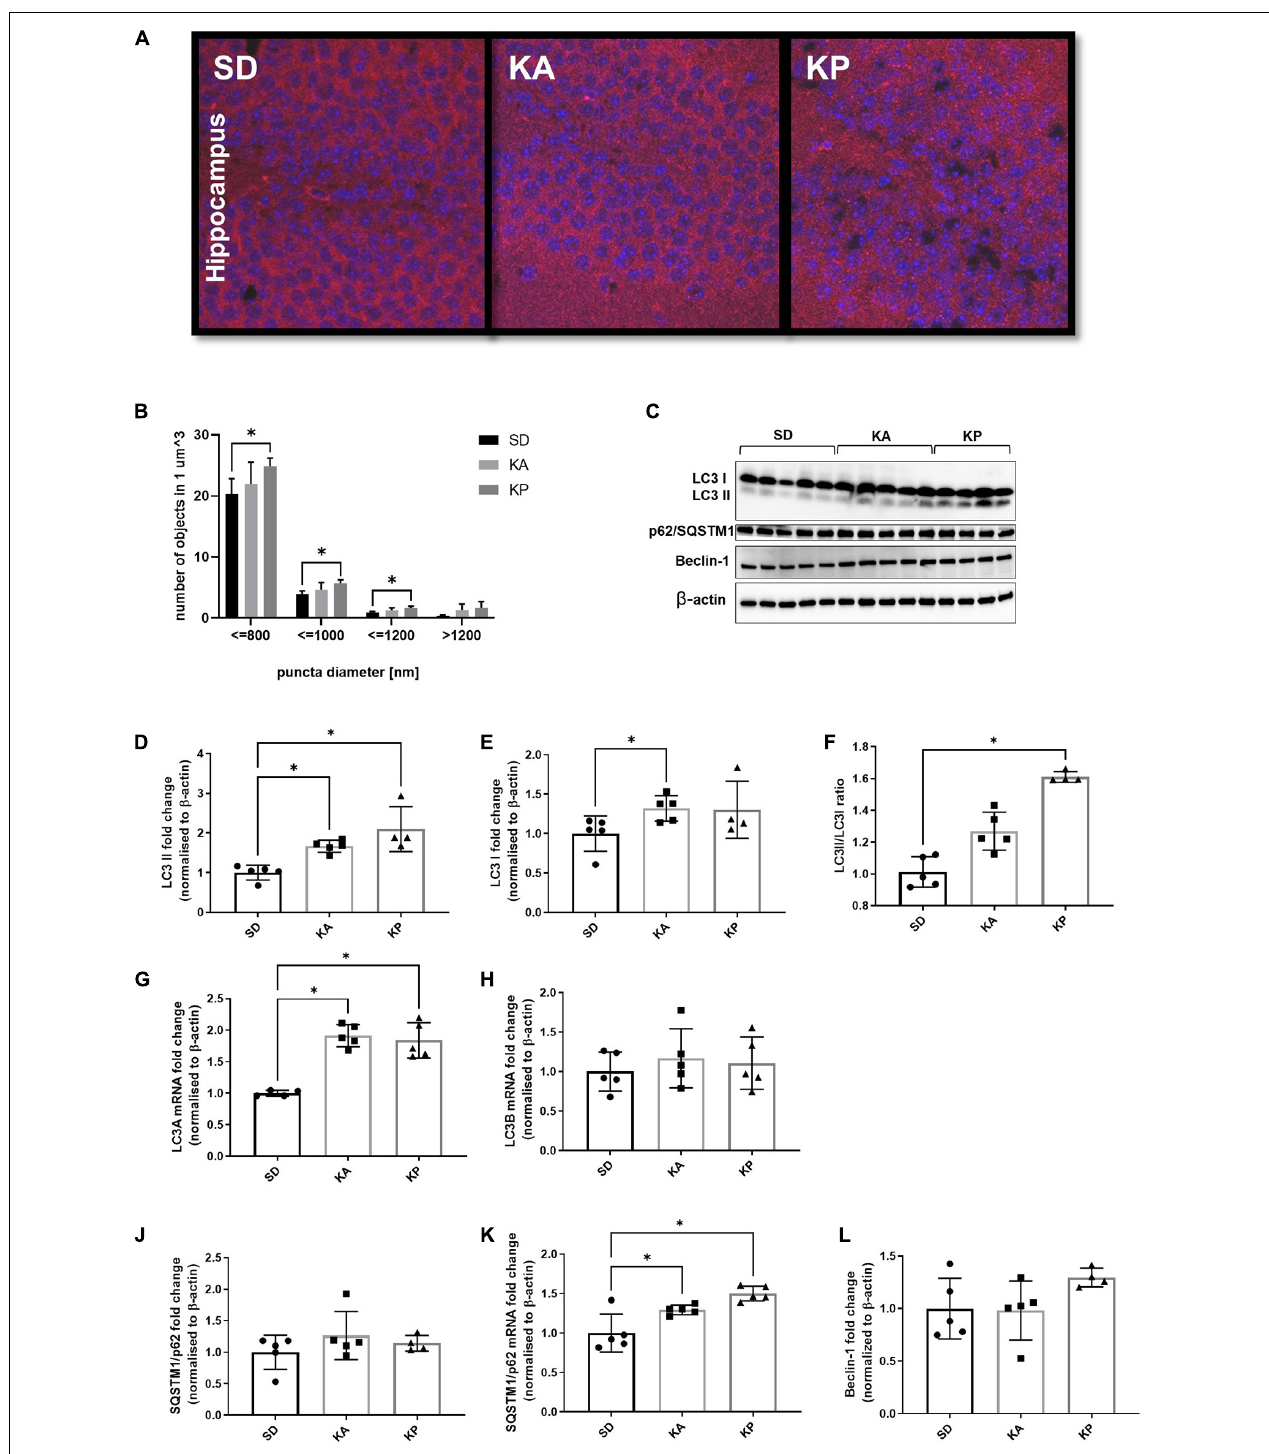
FIGURE 1 | The level of autophagy markers in the hippocampus of the mice fed with the ketogenic diets. (A) The hippocampi were immunolabeled against LC3 protein (red) and the level of LC3-positive puncta was counted in dentate gyrus ( n = 5). The nuclei are shown in blue (DAPI). (B) Number of LC3 puncta per 1 µ mˆ3 of tissue; the counted objects were divided into four categories based on their diameter. (C) LC3, SQSTM1/p62, and Beclin-1 with matched β -actin blots. Quantification of (D) LC3-II, (E) LC3-I protein levels and (F) its ratio. (G) Quantification of LC3 A and (H) LC3 B mRNA levels. (J) Quantification of SQSTM1/p62 and (K) its mRNA level. (L) Quantification of Beclin-1 level. The data is presented as a mean ± standard deviation, * indicates statistically significant changes ( p < 0.05). SD marks a group of control animals fed with standard chow, while experimental mice were maintained on the ketogenic diet composed of fat of animal (KA) or plant (KP) origins.